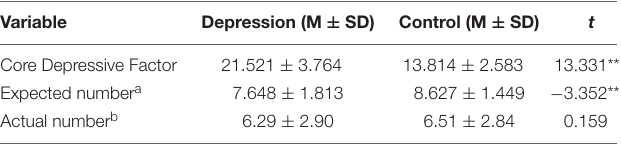
TABLE 2 | Core Depressive Factor scores and the actual and expected numbers of SPM problems solved at baseline.